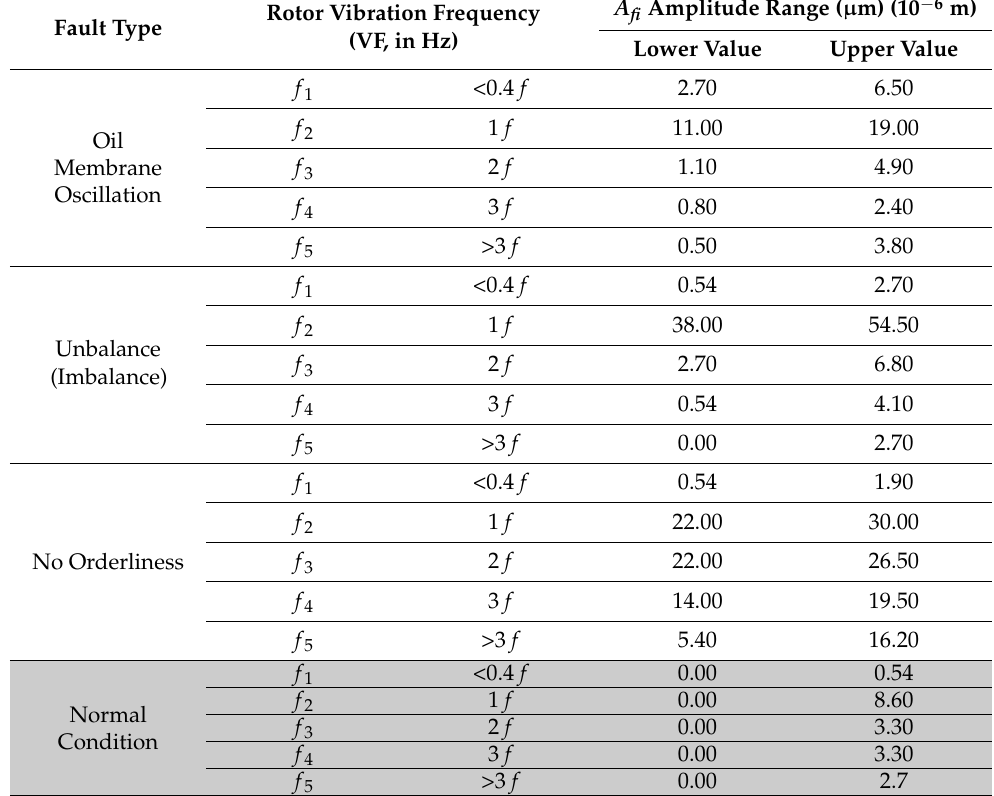
Table 1. Limits of Power Spectra in the Frequency Domain